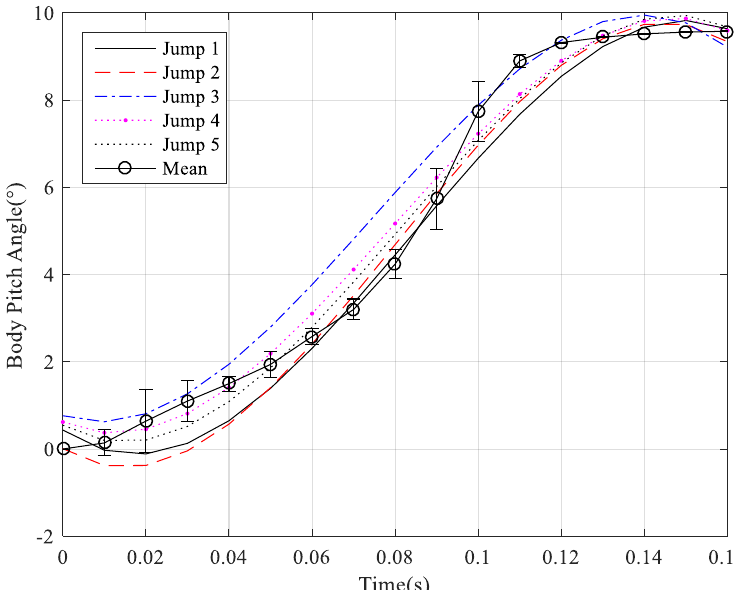
Figure 26. Experimental results for pitching adjustment when the forelimbs are actuated.